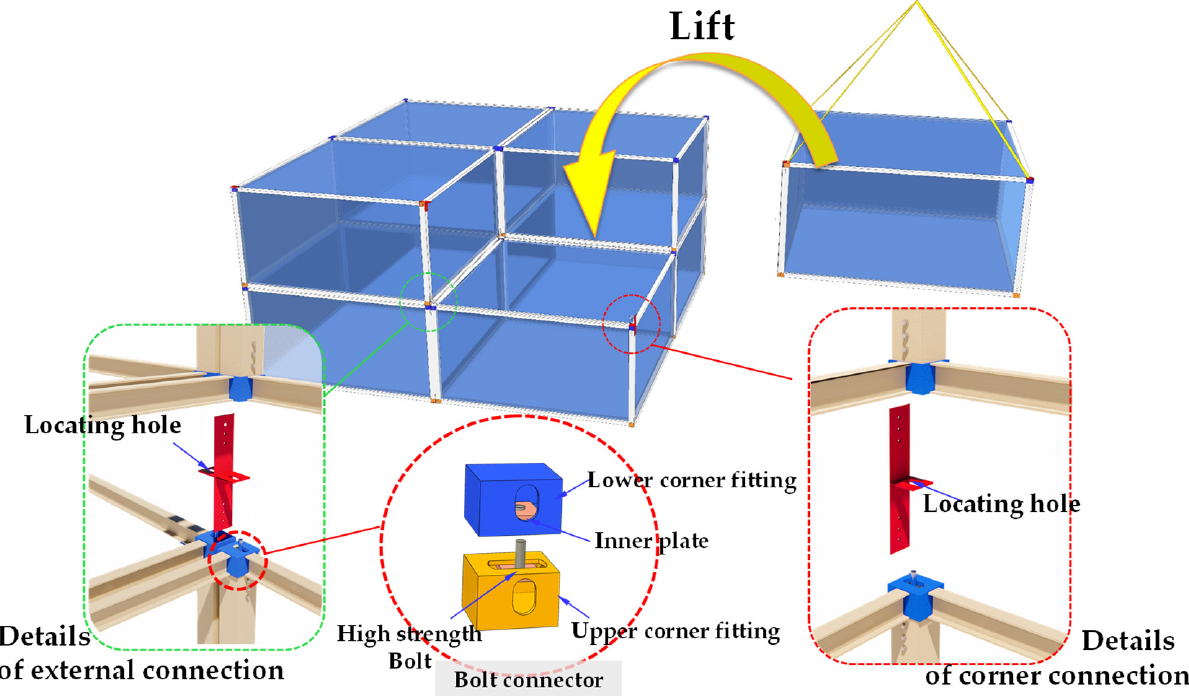
Figure 3. Details of the innovative connection.